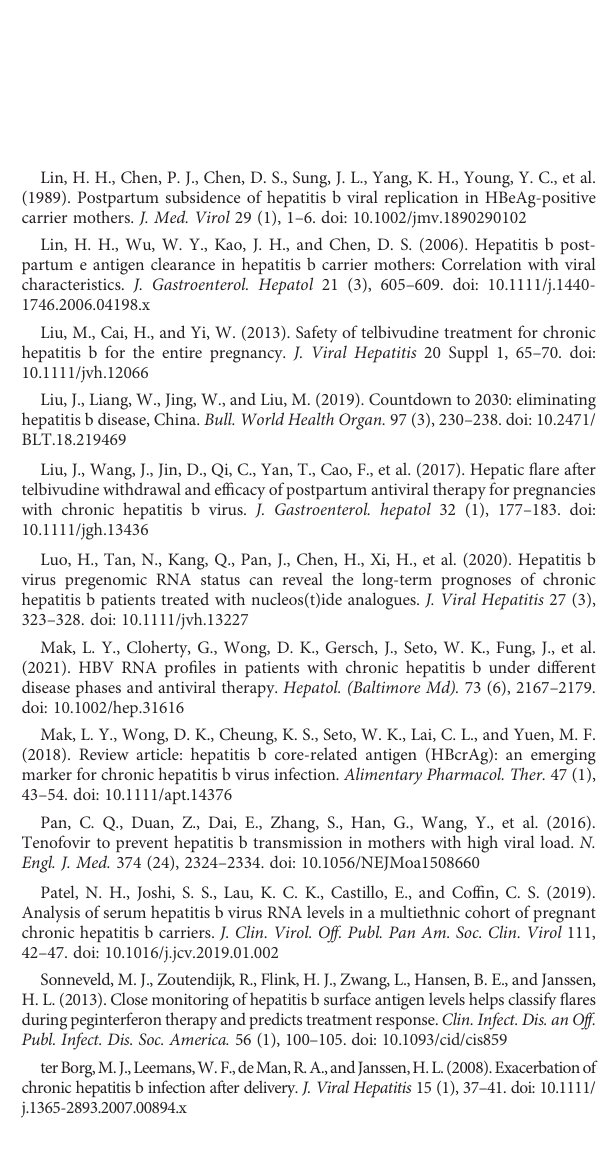
SUPPLEMENTARY TABLE 2 Prediction of HBsAg reduction by HBV biomarker cutoffs. SUPPLEMENTARY TABLE 3 Prediction of HBeAg seroconversion by HBV biomarker cutoffs.